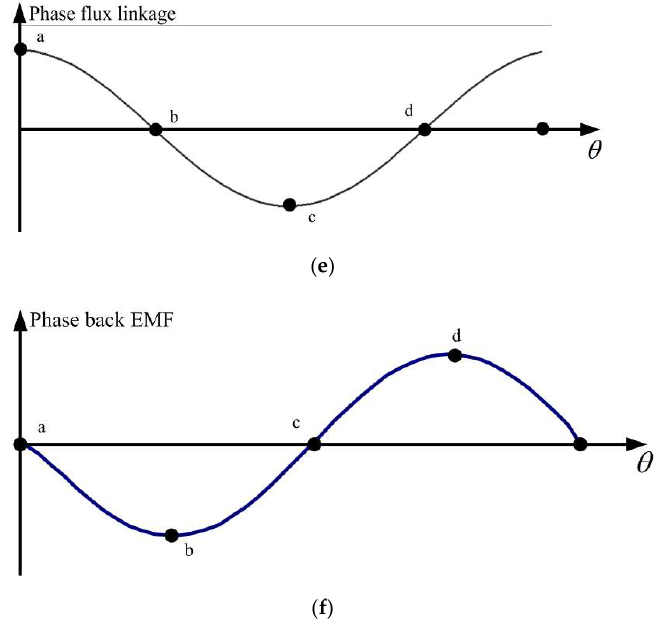
Figure 2. Relative position between rotor and stator of VFMPM machine, and the corresponding variation of flux linkage and phase back EMF. ( a ) Position a; ( b ) Position b; ( c ) Position c; ( d ) Position d; ( e ) Phase flux linkage waveform; ( f ) Phase back EMF waveform.